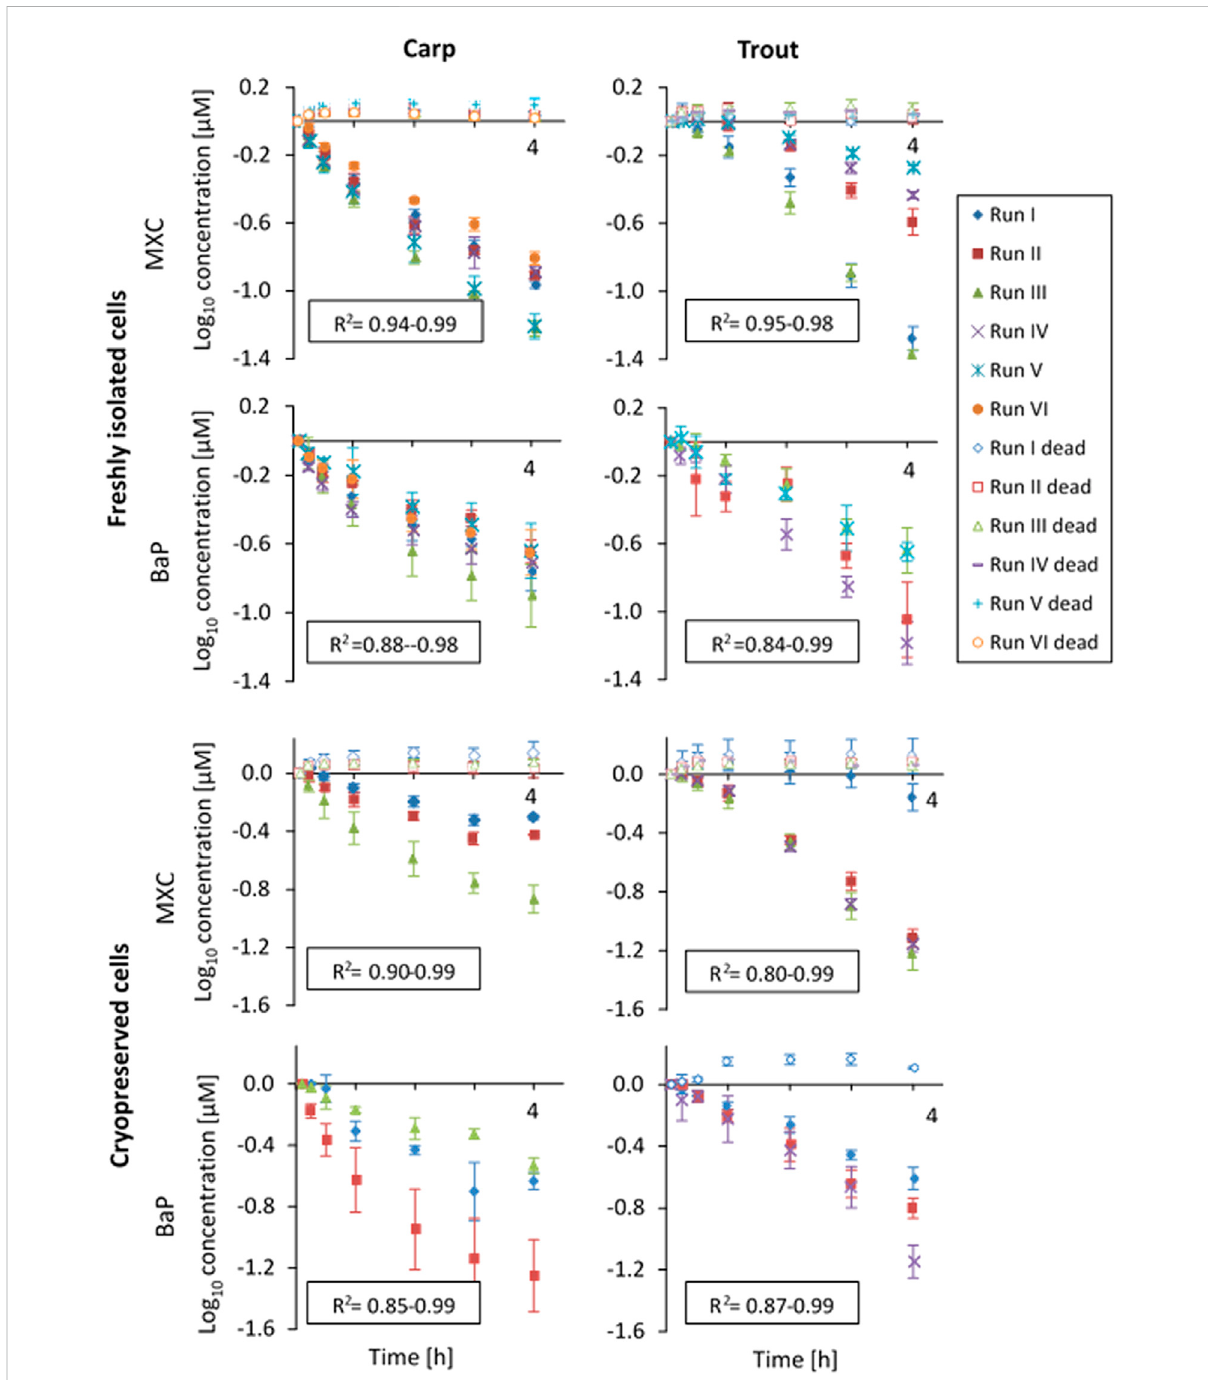
FIGURE 1 fi rst sampling time point) from In vitro substrate depletion curves (measured concentrations were log 10 -transformed and normalized to the biotransformation rate assays with freshly isolated or cryopreserved common carp and rainbow trout hepatocytes. The cells were incubated over a 4-h-period ( x -axis). Data points represent average substrate concentrations for each experimental run over the 4 h incubation period. Error bars indicate the standard deviation between triplicates. R 2 -values of the linear regressions are given for live replicates as a measure of goodness of fi t. “ Dead ” indicates control values obtained with heat-inactivated